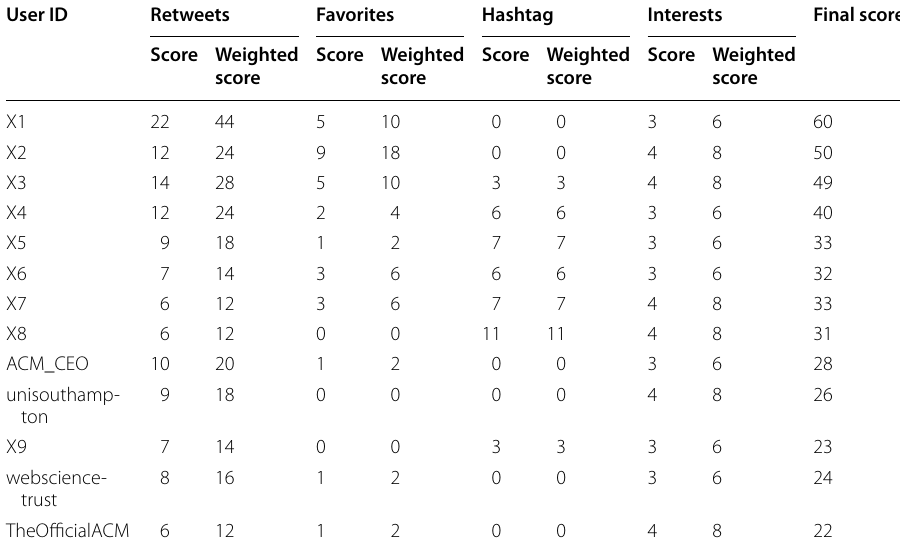
Table 4 Content based configuration results break-down of scores